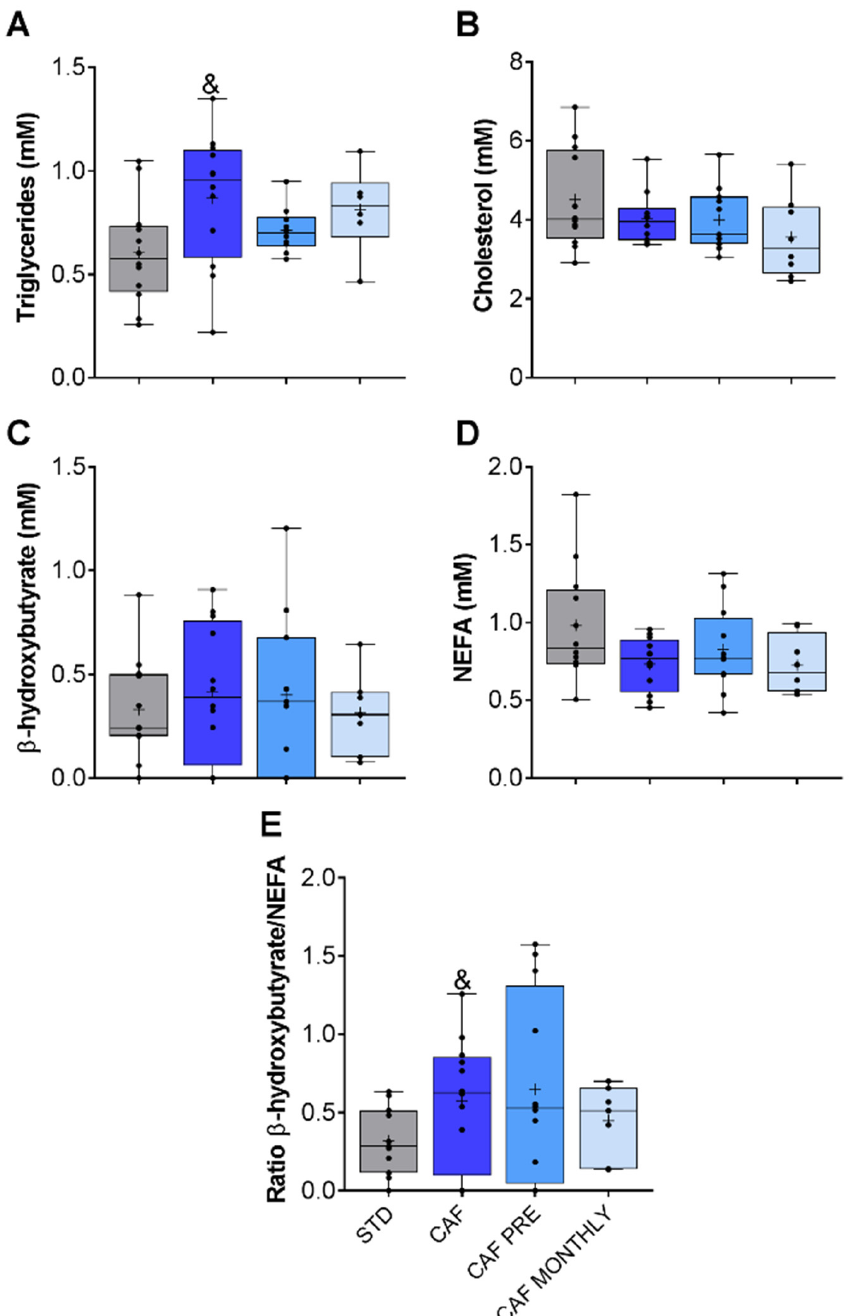
Figure 4. Lipid metabolism-related biochemical parameters. ( A ) Triglyceride levels. ( B ) Cholesterol levels. ( C ) β -hydroxybutyrate levels. ( D ) NEFA levels. ( E ) β -hydroxybutyrate/NEFA ratio.